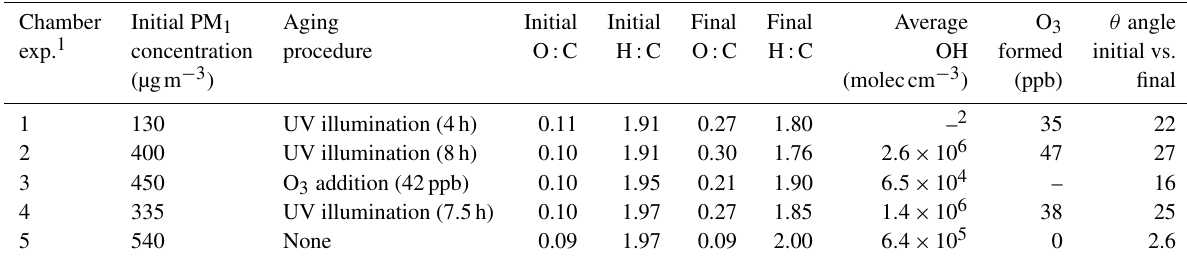
Table 1. Summary of smog chamber experiments. Chamber Initial PM 1 Aging concentration